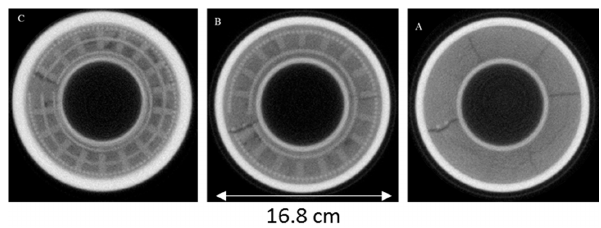
Figure 16. High-energy neutron CT scan of a heavy tungsten-encased ceramic cathode assembly— cathode is shown in front of flat panel in Figure 15 left photo. Cracks in the ceramic are difficult to impossible to image with X-rays. Slices in three different planes show ( A ) ceramic with cracks ( B ) spiral wound heating element near edge and center of ceramic ( C ) central support of heating element.